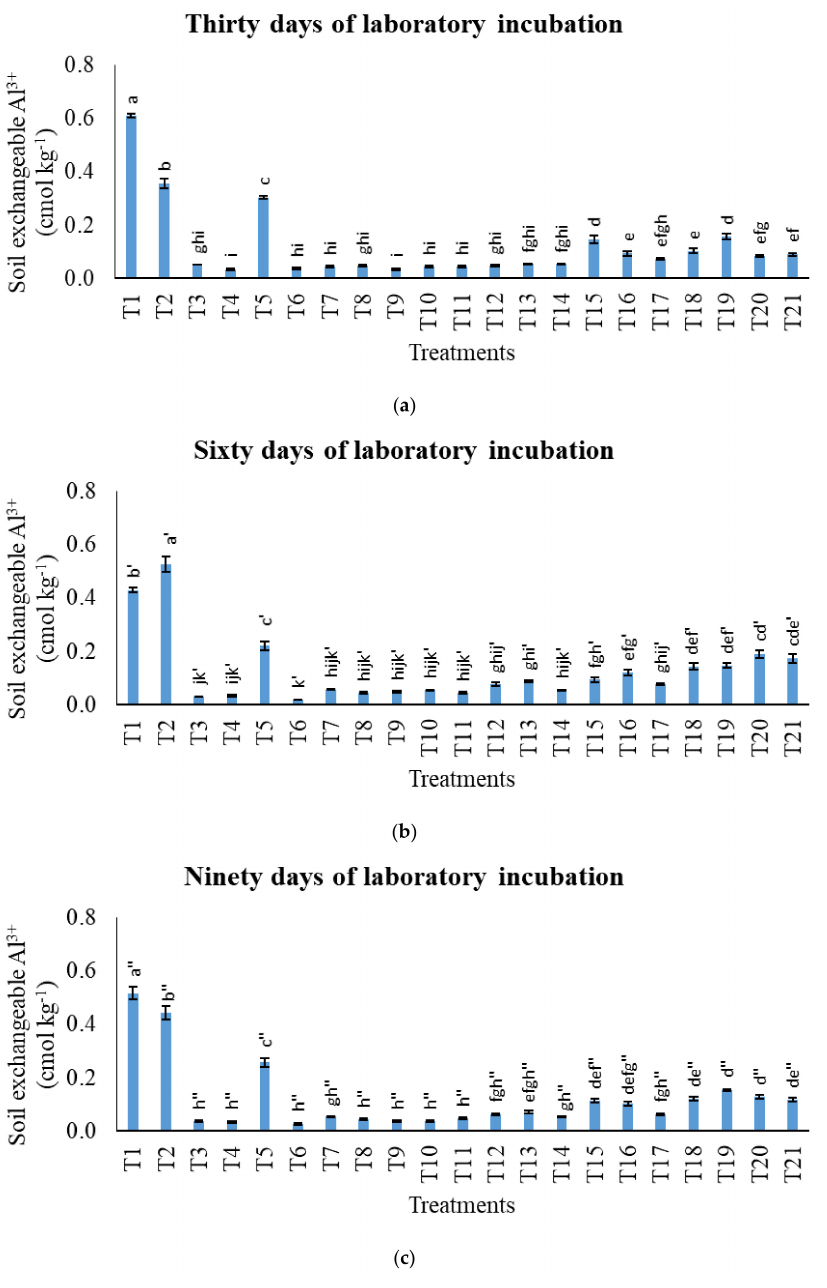
Figure 3. Effects of treatments on soil-exchangeable aluminium over ( a ) thirty; ( b ) sixty; and ( c ) ninety days after incubation. T1: soil control, T2: conventional practice, T3: muriate of potash + 100% charcoal + 100% sago bark ash,